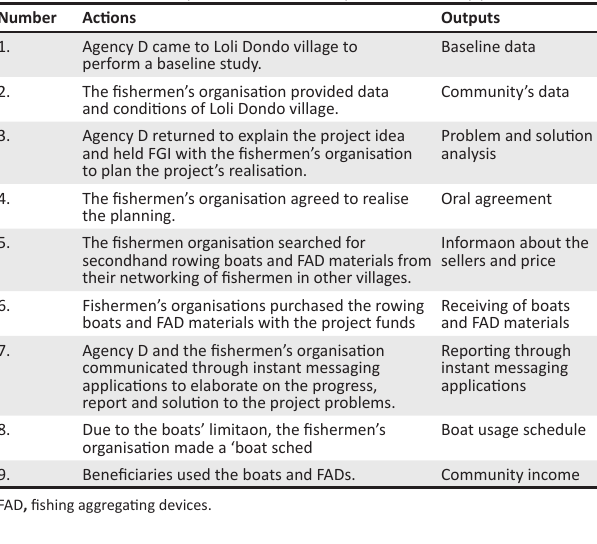
TABLE 4: Actions and outputs from community-driven recovery